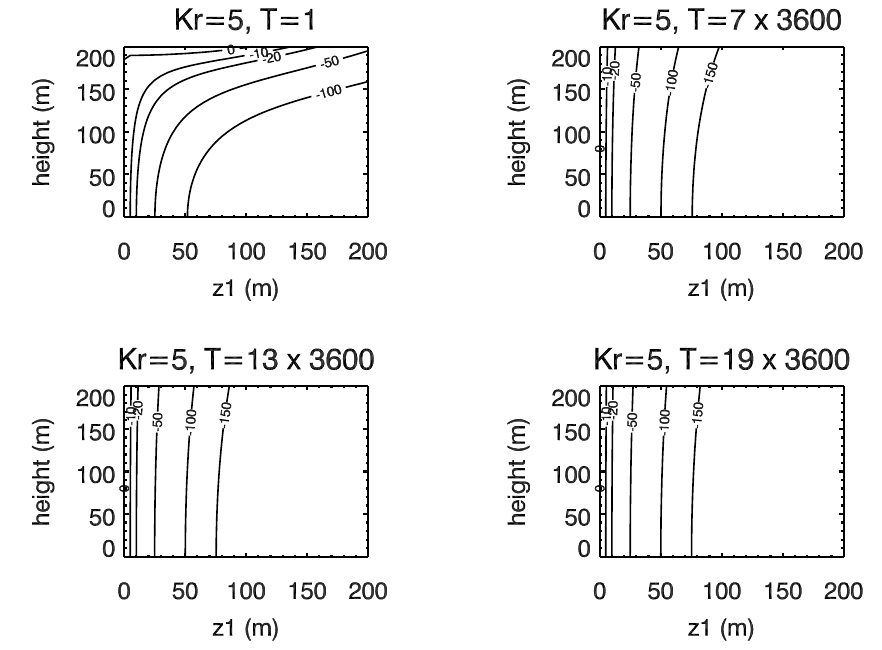
Figure 2. Same as Figure 1 but with K t =